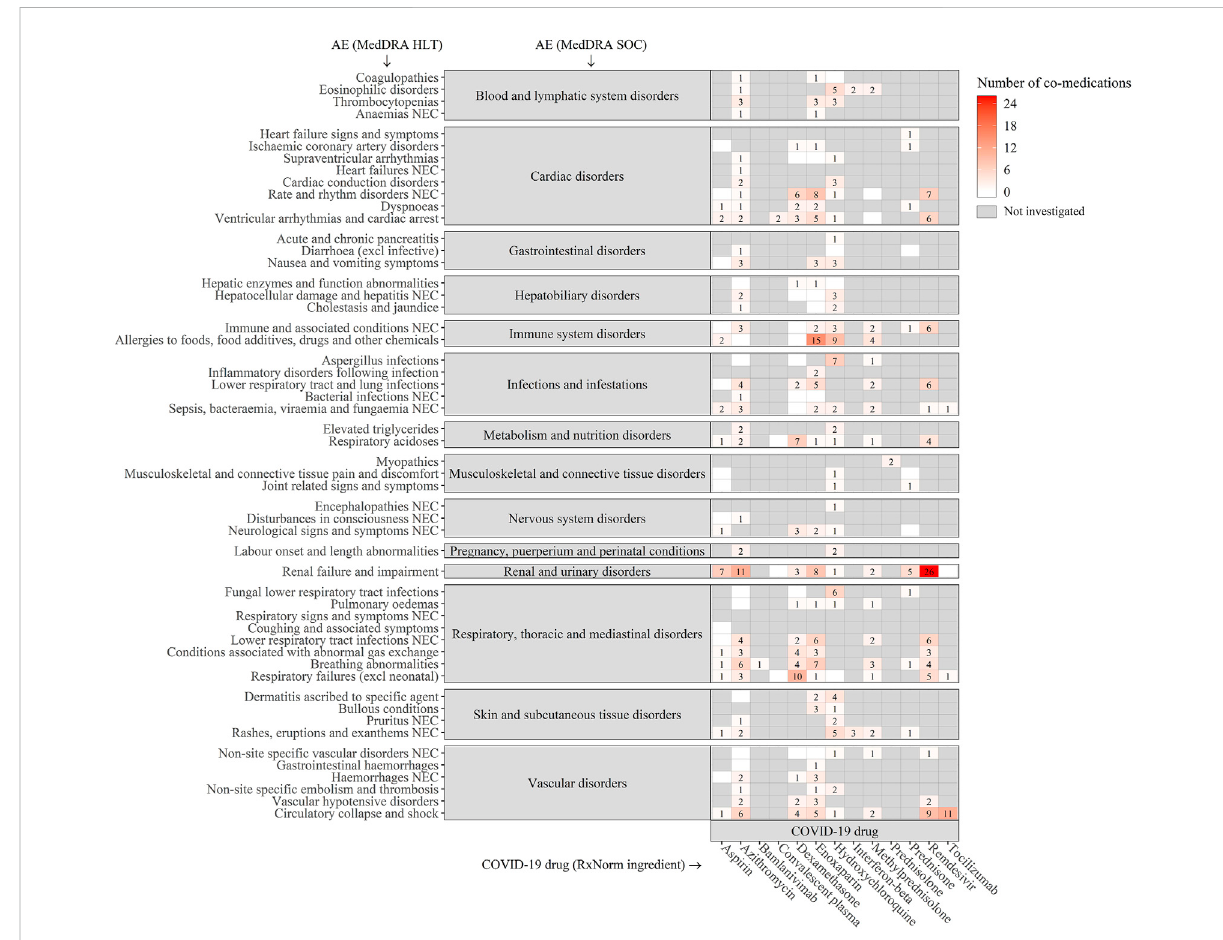
FIGURE 5 Heatmapdepictingstatisticallysigni fi cantassociationsbetweentheCOVID-19drugs(onthebottom)andMedDRAHLTs(clusteredbyMedDRA SOC, on the left). The cells were colored white to red according to the number of drugs in the co-medications that caused an AE when combined with a drug in the COVID-19 drugs (grey if there was insuf fi cient data in the FAERS database to investigate